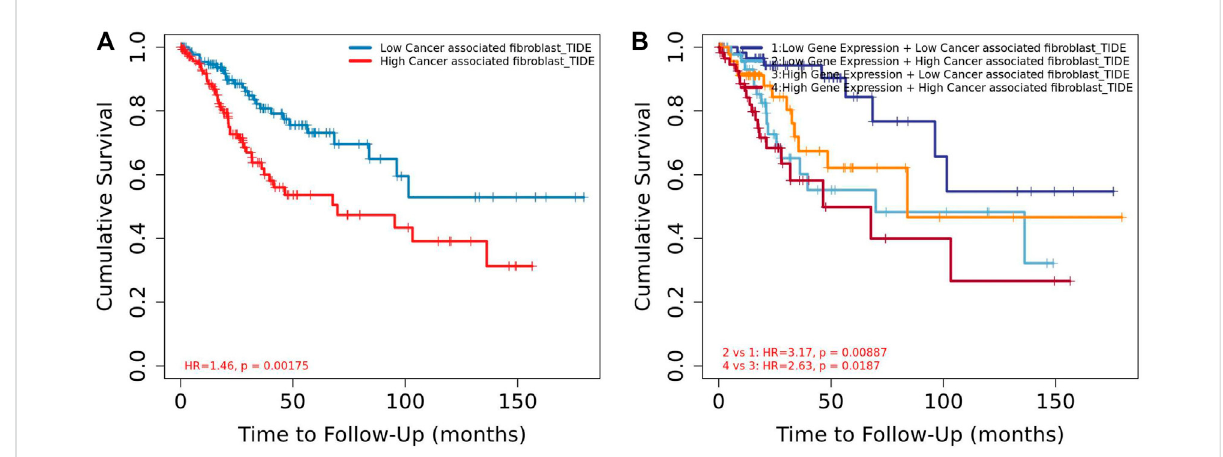
FIGURE 9 Association between CAF and overall survival in Timer2. (A) Low CAF had high overall survival rate than high CAF. (B) Low CAF + low SOX9 expression group had high overall survival rate than the high CAF + high SOX9 expression